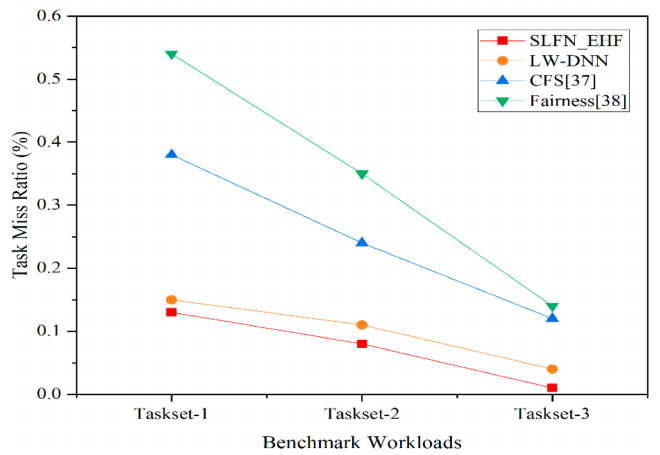
Figure 13. Task miss rate (TMR) analysis observed on Hardware Configuration-2 for the execution of Benchmark Workloads.